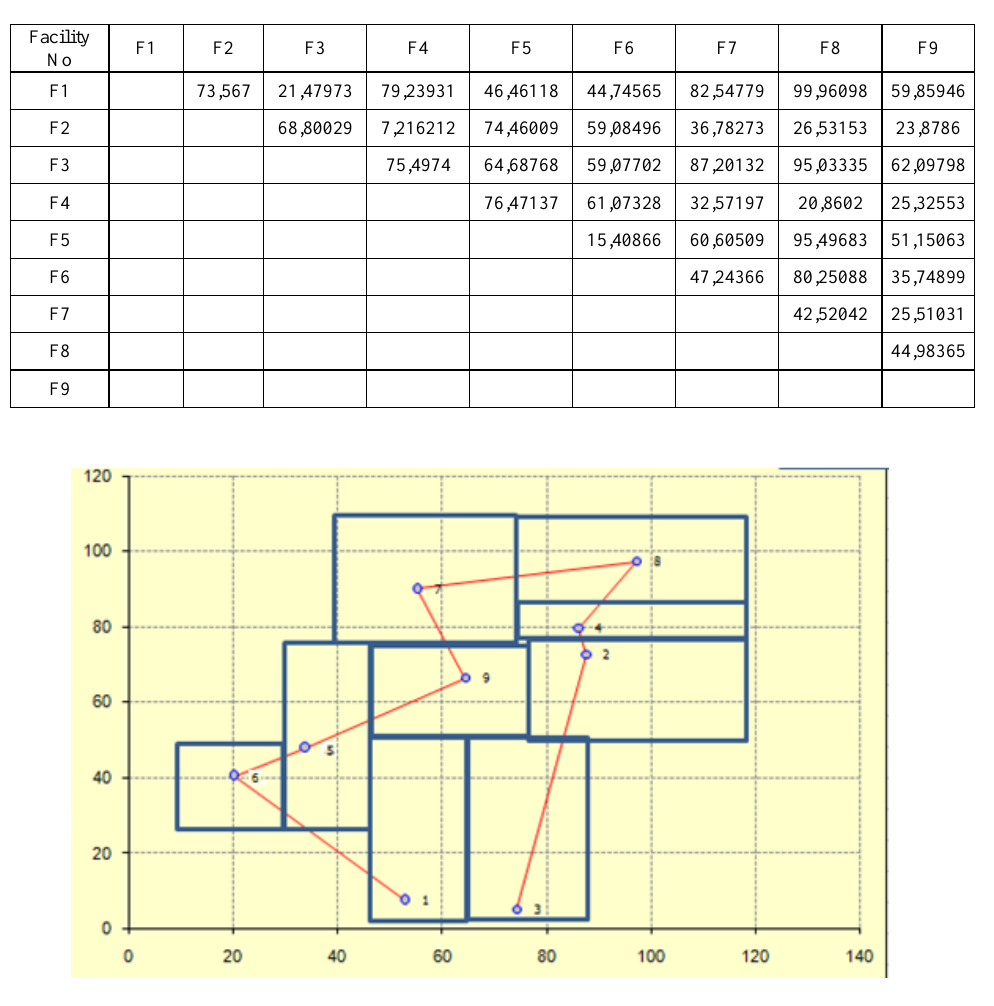
Fig. 2. Sample facility layout